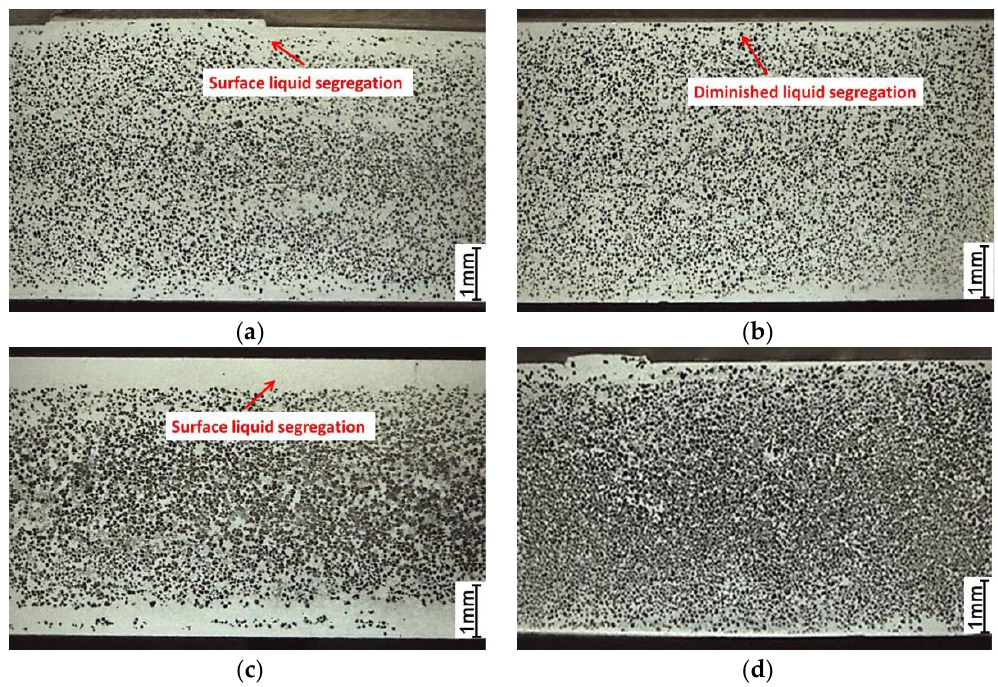
Figure 10. Macro-distribution of the primary α -Mg phase in rheo-diecast AZ31 alloy with solid fractions of 0.42 ( a , b ) and 0.61 ( c , d ) at an injection velocity of 0.5 m/s ( a , c ) and 3 m/s ( b , d ).